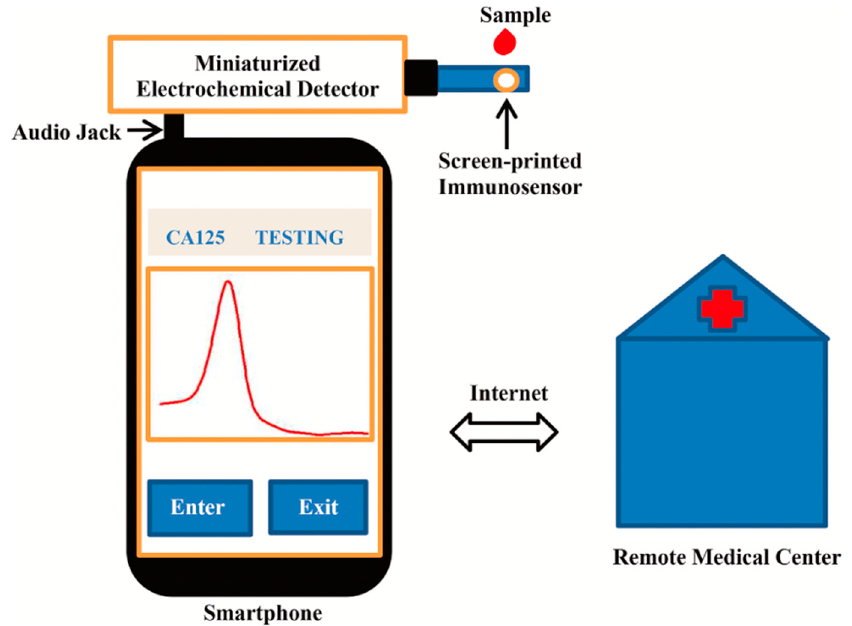
Figure 6. Schematic of the multi-walled carbon nanotube-based electrochemical sensor. Reprinted with permission from Michrochemical Journal, Copyright 2022, Elsevier [28].